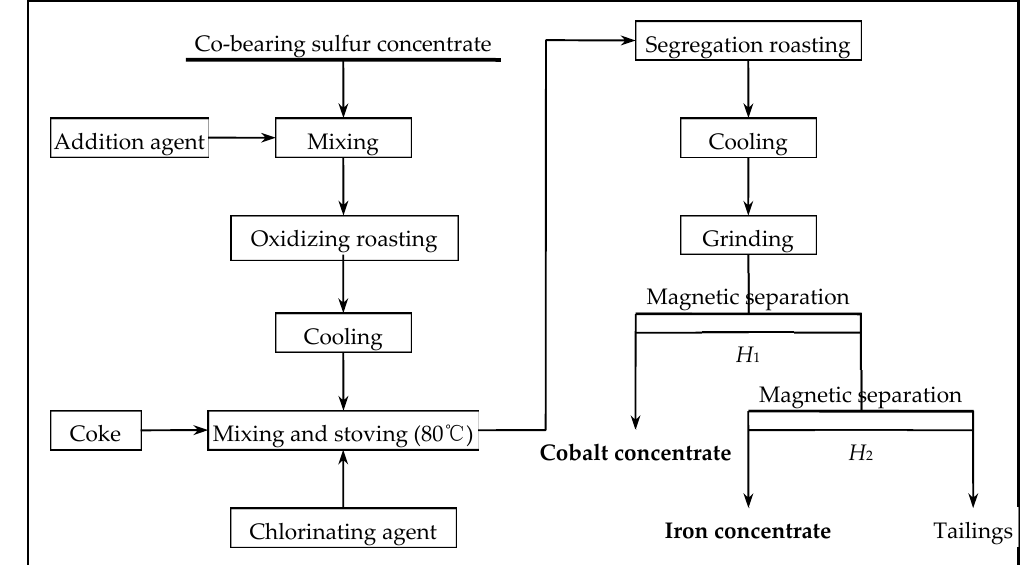
Figure 2. Scheme of the Co and Fe extraction process from Co-bearing sulfur concentrate.